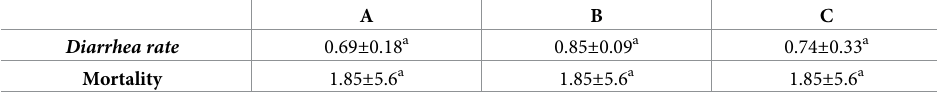
Table 7. Effects of C . sartagoforme XN-T4 on the diarrhea rate and mortality of Rex rabbits